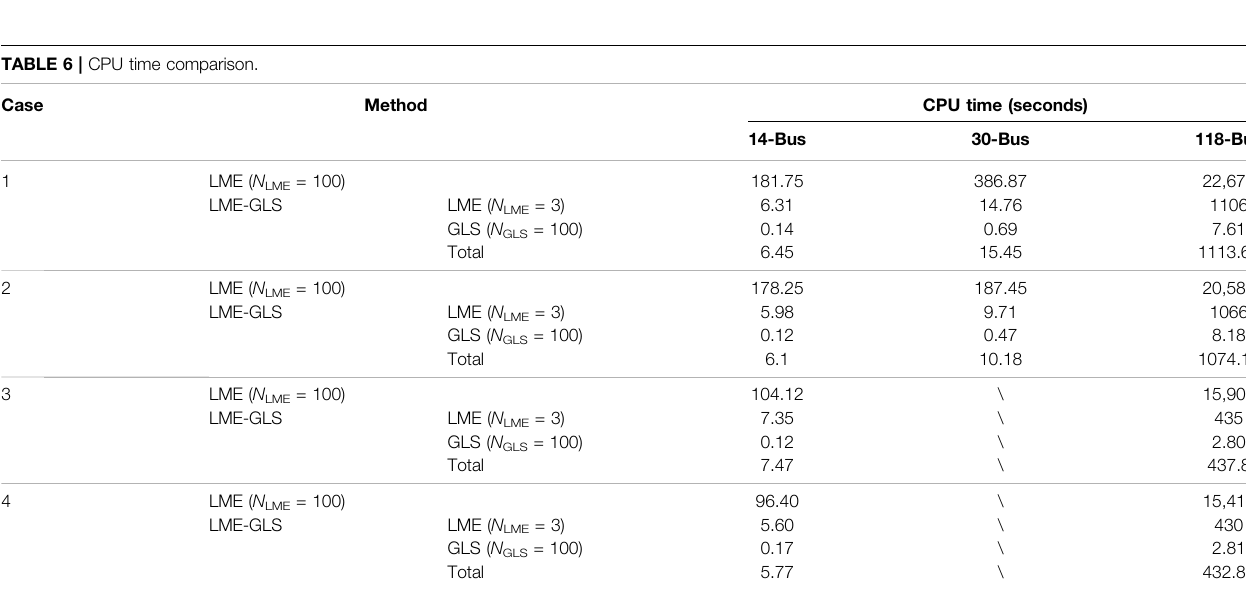
TABLE 6 | CPU time